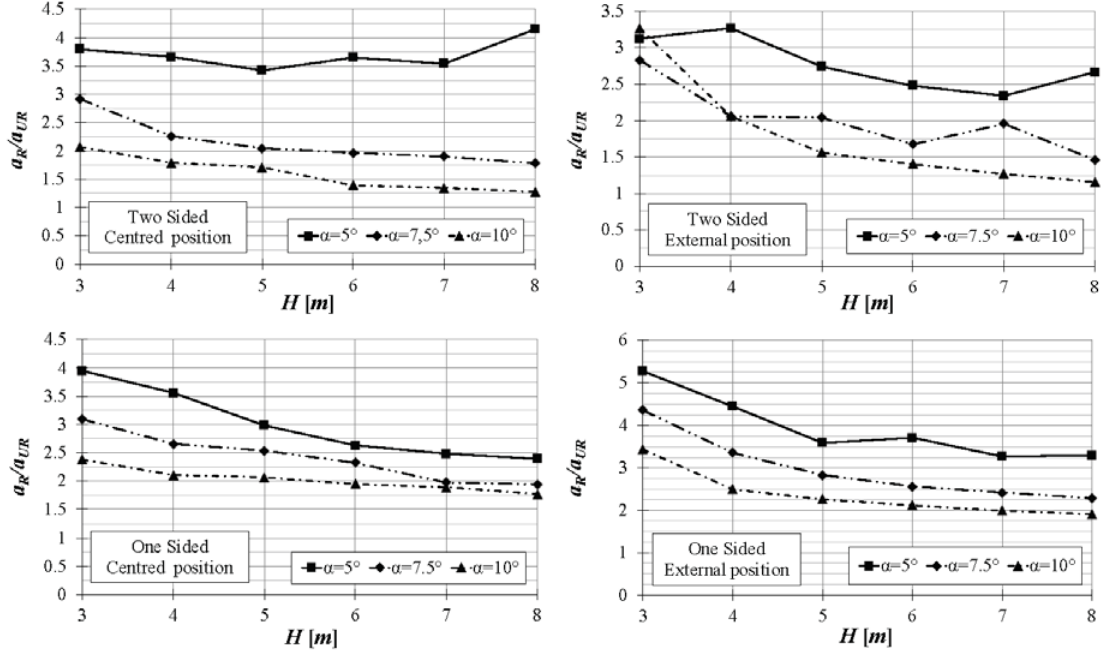
Figure 14. Level of seismic improvement versus height H — ρ =2‰, Spectrum A2 , GFRP material.